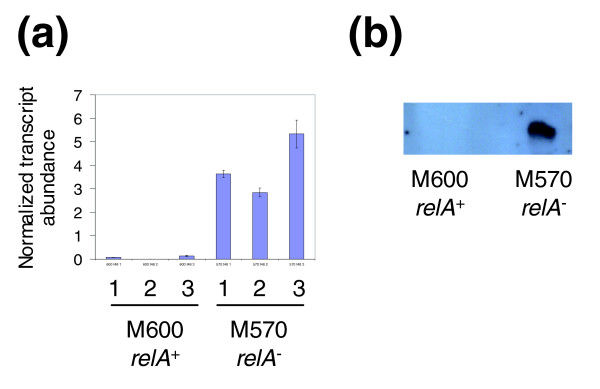
Comparison of SapB expression in M600 (relA+ ppGpp+) and M570 (relA- ppGpp-). (a) qRT-PCR confirms that transcription of sapB in the 48 h samples is approximately 40-fold increased as a result of relA mutation. (b) This is reflected in a large increase in SapB extracted from M570 (relA-) cells harvested after 48 h growth on MYM TE agar, as detected by Western blotting. Lanes 1, 2 and 3 indicate biological replicate samples. The average of three qRT-PCR determinations is shown, and standard deviations are marked with error bars. Western analysis was performed on biological duplicate samples, and a representative result is shown.